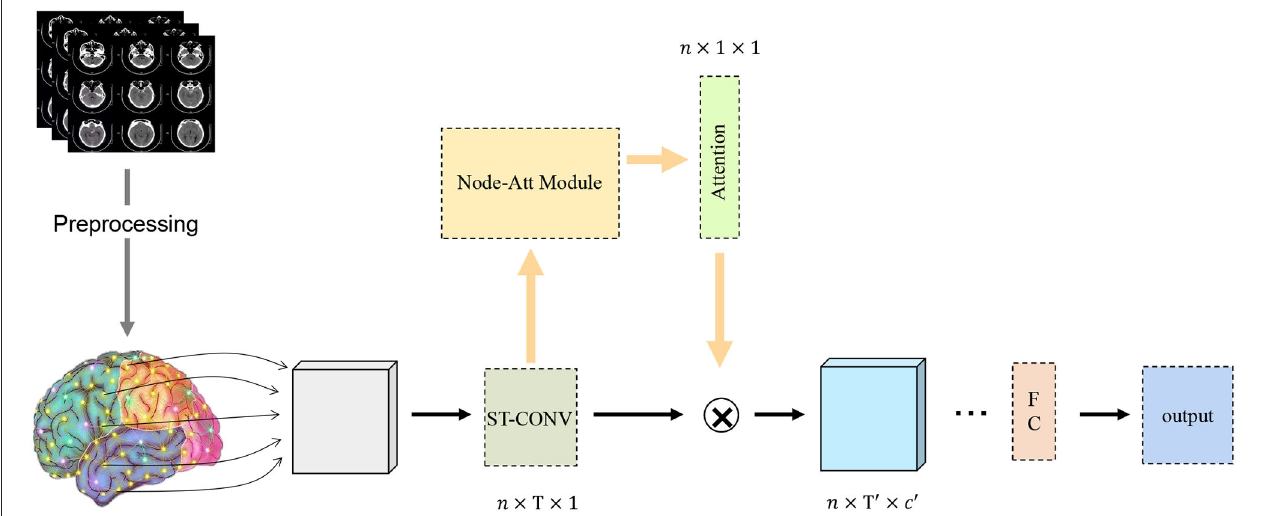
FIGURE 1 | Deep Spatiotemporal Attention Network (DSTAN) structure illustration. Spatiotemporal convolution strategy (ST-CONV) represents spatiotemporal convolution, Node-ATT Module represents Attention module of brain functional Node, Attention represents brain node attention map and FC represents full connection layer. n represents the number of brain nodes, and T, T ′ represents the number of time points of functional brain signals. c ′ is the number of channels.